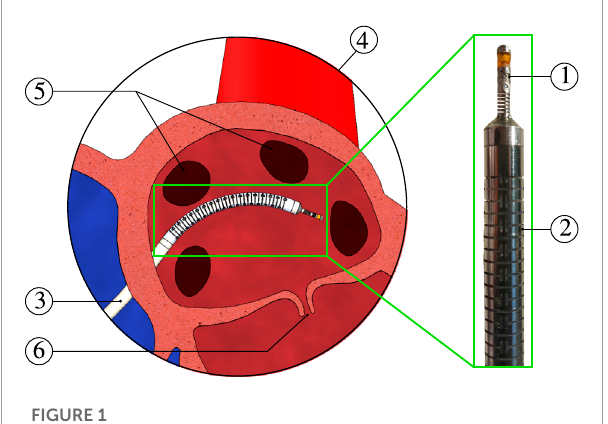
FIGURE 2 Force sensor overview ⓐ exploded view ⓑ assembled view ⓒ sectional view illustrating the relevant spring dimensions such as total length L , wire thickness t , wire breath b , and mean coil diameter D . The central FBG location along the spring’s length is given as L FBG . The sensor’s components include: ① MCF, ② FBGs, ③ ablation electrodes, ④ insulation ring, and ⑤ side holes to inject adhesives for MCF